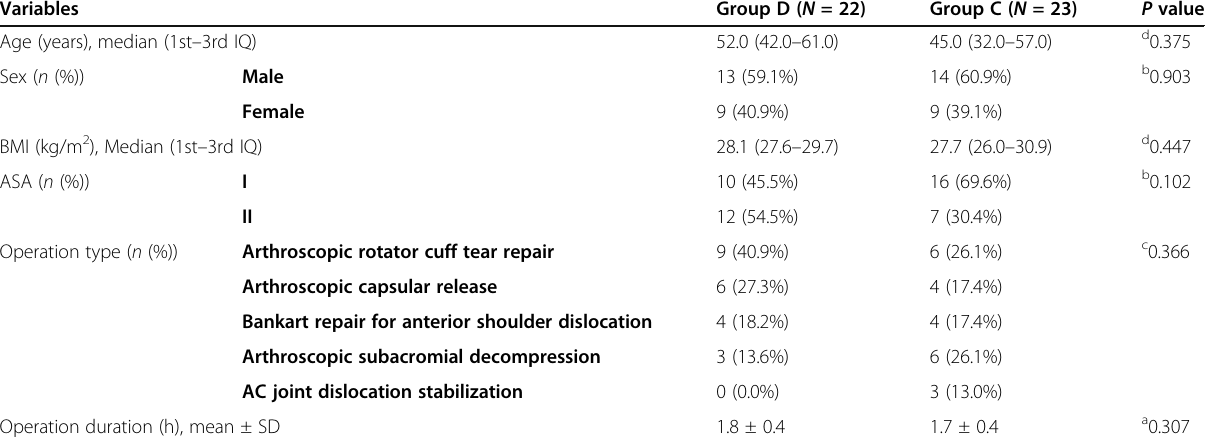
Table 1 Comparison between the C group and D group according to demographics, surgery type, and duration